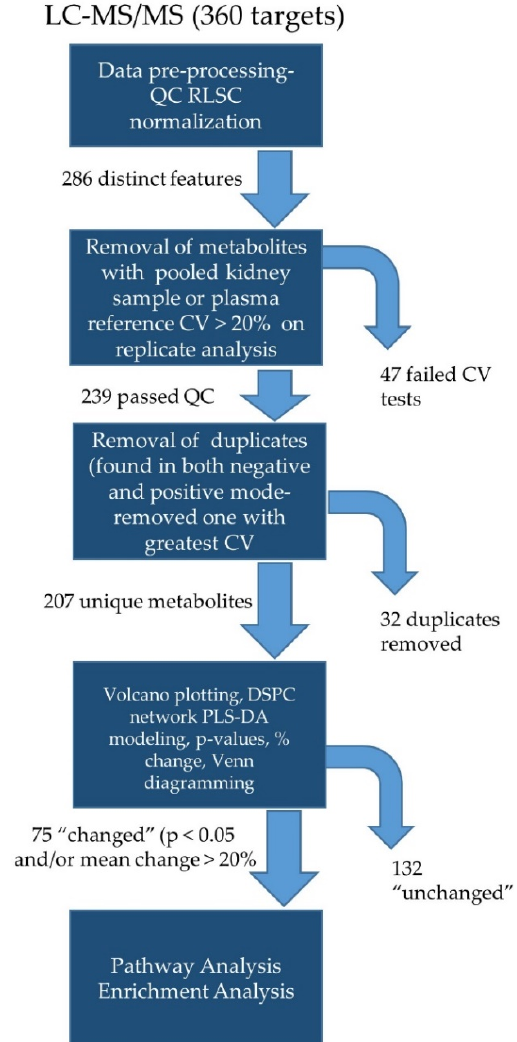
Figure 1. Workflow for targeted metabolomics. Peak pre-processing included quality-control-based robust LOESS signal correction (QC RLSC) for signal drift and batch correction. CV- coefficient of variation- used to determine stability of signal (>20% on replicates excluded). DSPC- debiased sparse partial correlation; PLS-DA- partial least squares differential analysis.